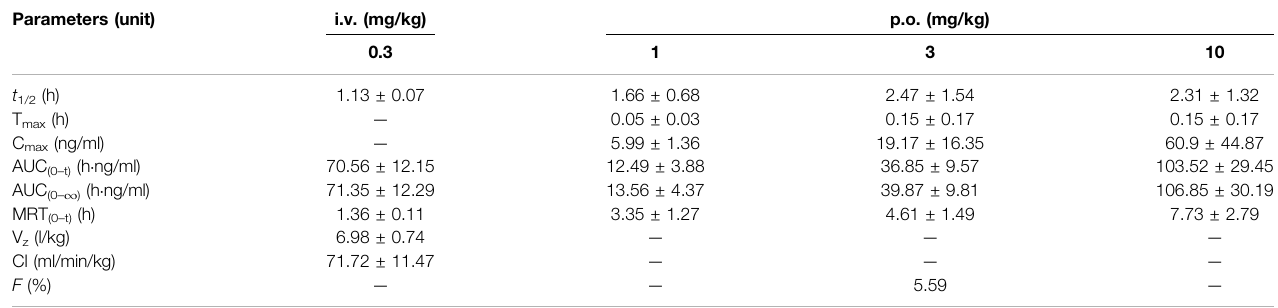
TABLE 4 | Pharmacokinetic parameters of YL-IPA08 in rats after intravenous and oral administration (n (cid:2) 6). Parameters (unit)